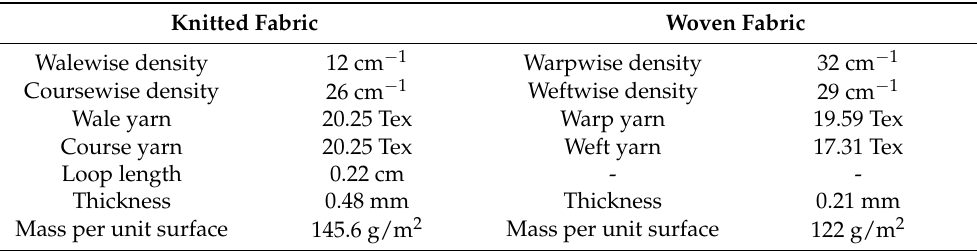
Table 1. Structural characteristics of woven and knitted and woven fabric. Knitted Fabric Woven Fabric Walewise density 12 cm − 1 Warpwise density 32 cm − 1 Coursewise density 26 cm − 1 Weftwise density 29 cm − 1 Wale yarn 20.25 Tex Warp yarn Course yarn Weft yarn Loop length 0.22 cm - Thickness 0.48 mm Thickness Mass per unit surface 145.6 g/m 2 122 g/m